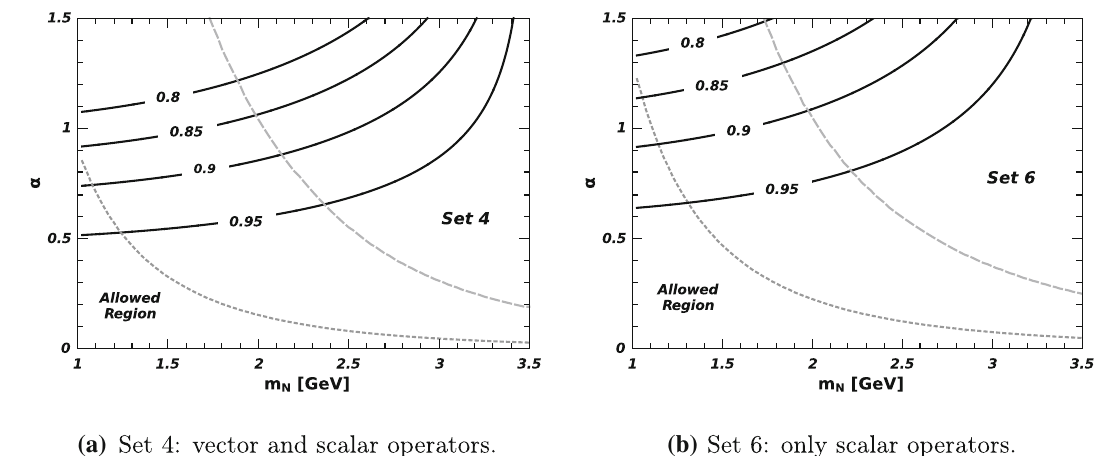
Fig. 1 Tau polarization P τ contours (solid black), and allowed regions in the ( m N ,α) plane (dotted and dashed) for B → τν decay Fig. 2 Schematic representation for the effective contribution to the decay B − → (cid:2) −